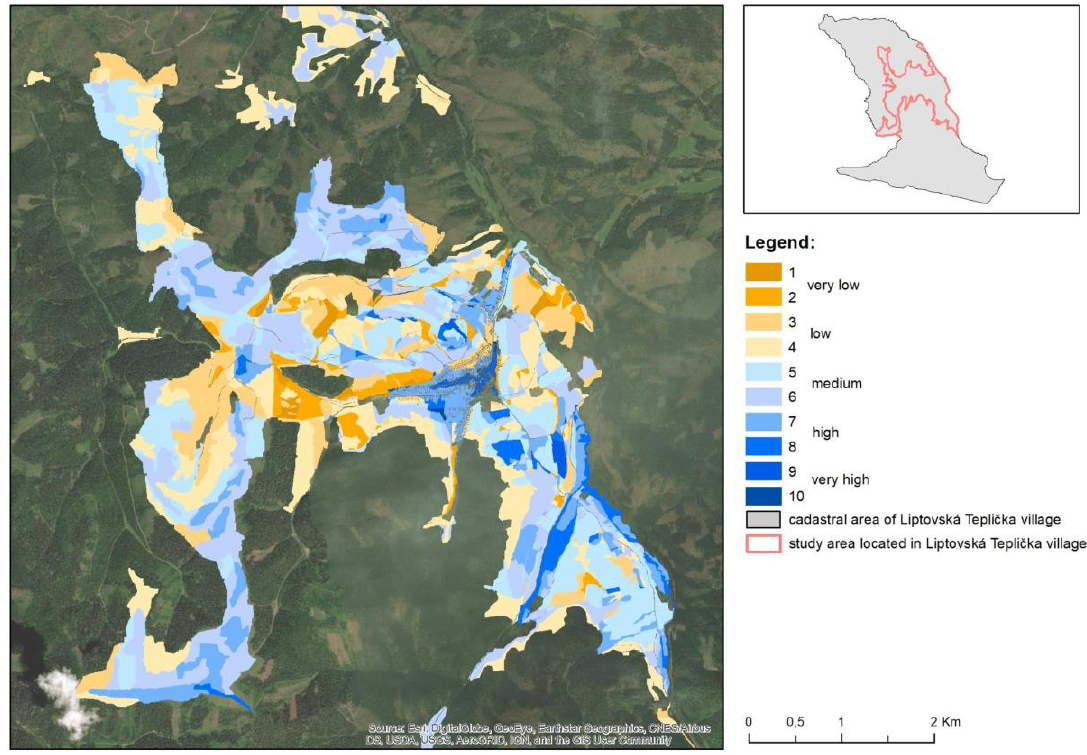
Figure 8. Spatial differentiation of LWRC in Liptovská Teplička. Source: Base map, Esri, 2020.